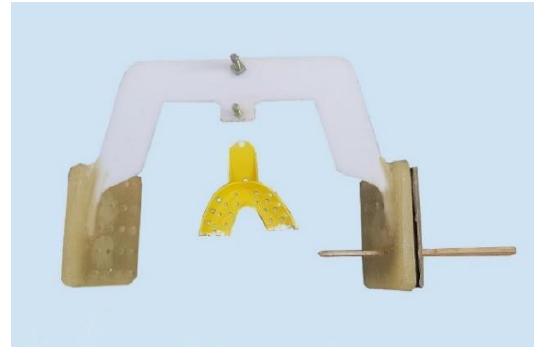
Figure 4: Swelling measurement device The technique of measurement was: Making an impression for the upper teeth by modified disposable tray after checking its fitness in the patient mouth, removal of the tray from the